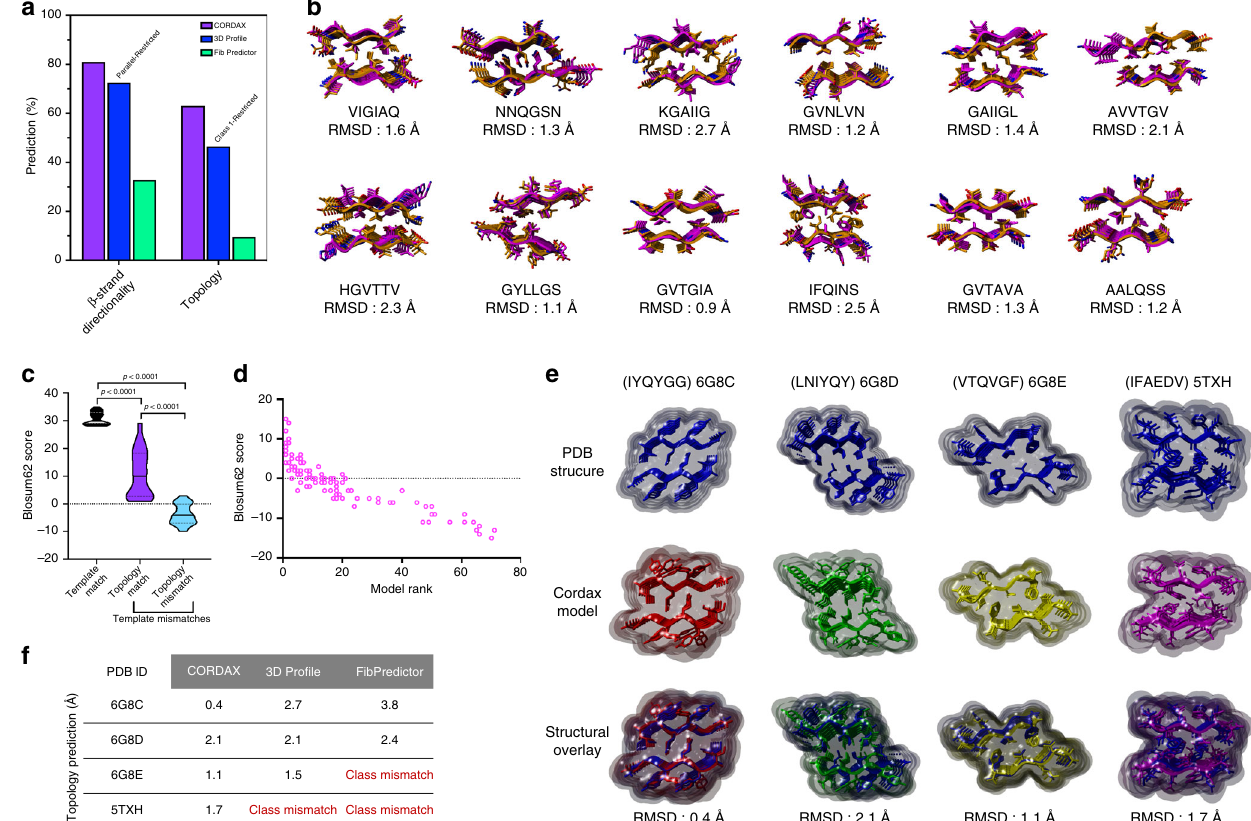
Fig. 7 High-precision recognition of amyloid fi bril structural architectures using Cordax. a Prediction accuracy comparison of Cordax to the only publicly available structural predictors, Fibpredictor and 3D-pro fi le. For comparison, methods were run against a non-redundant sequence set extracted from amyloid-forming peptide interfaces ( n = 73 templates). b Model topologies, predicted by applying Cordax (shown in orange), strongly superimpose to matching solved structural layouts of amyloidogenic nucleators (shown in magenta), as indicated by the reported minor RMSD values. c Sequence identity contribution for template selection during cross-threading analysis of the Cordax structural library. Alignment scores for selected models matching the template sequences compared to mismatching template selections of similar or different topological layouts ( n = 73 templates). d Alignment scores of the APRs newly identi fi ed by Cordax to the sequence of the selected templates, plotted against their corresponding model ranks ( n = 96 sequences threaded). e Structural alignment of Cordax outputs to experimentally determined 3D structures. Models were calculated for three aggregation prone sequences derived from CsgA curli forming protein (PDB IDs: 6G8C, 6G8D and 6G8E, respectively) and a peptide mutant sequence derived from A β amyloid peptide (PDB ID: 5TXH). Predicted topologies are overlapping representations of the experimentally determined amyloid fi bril cores, f as displayed by a direct comparison to other software. Violin plots represent the kernel probability densities of the data with the median, upper and bottom quartiles. Source data are provided as a Source Data fi